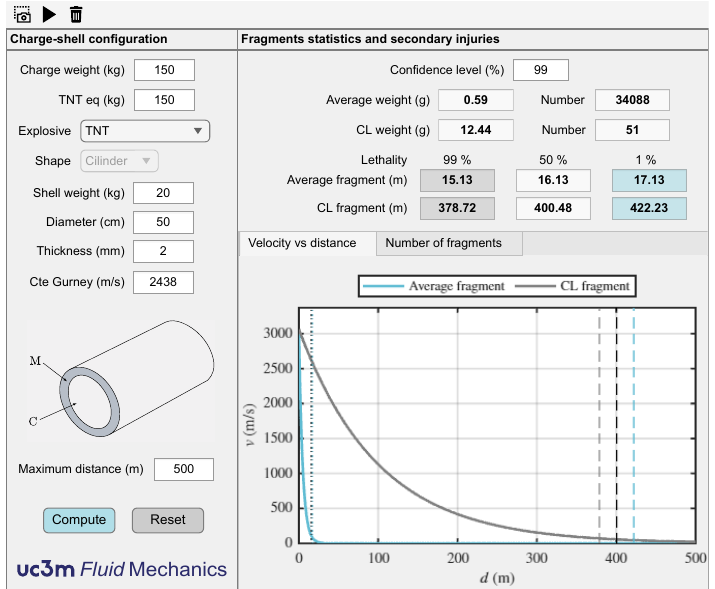
Figure 5. Interface of the primary fragment mass distribution and lethality assistant.